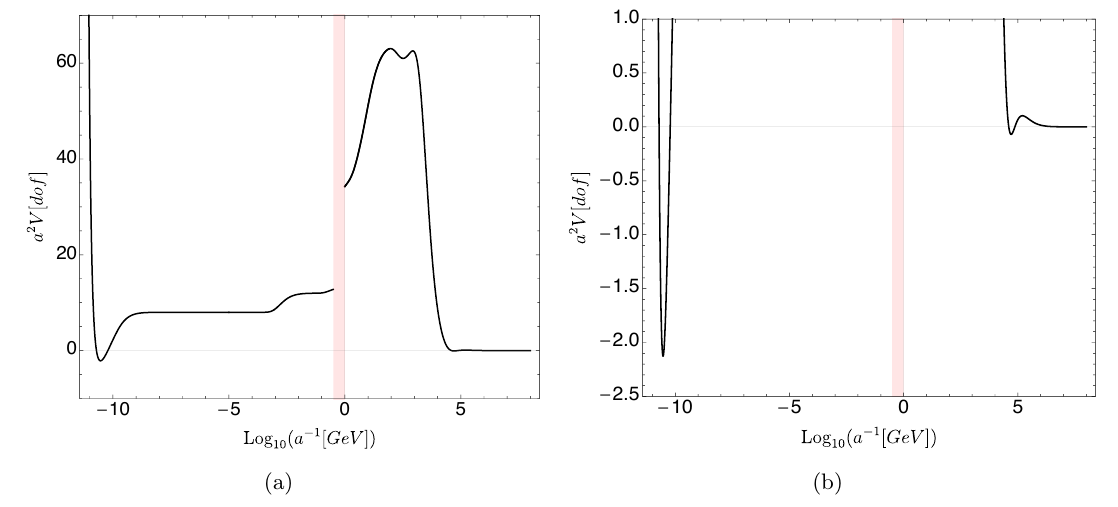
Figure 8 . E(cid:11)ective potential of the Standard Model compacti(cid:12)ed in T 2 =Z 4 and embedded into U(1) s . The masses of all superpartners of the SM particles are set to 1 TeV except for the gravitino (4 d.o.f.), m = 19 TeV and the s-goldstino (2 d.o.f.), m sgolds = 33 TeV. (b) displays a zoom in 3 = 2 of (a) and it can be seen that a Type P AdS minimum forms since it depends on the masses of the SUSY spectrum, hence giving some constraints from